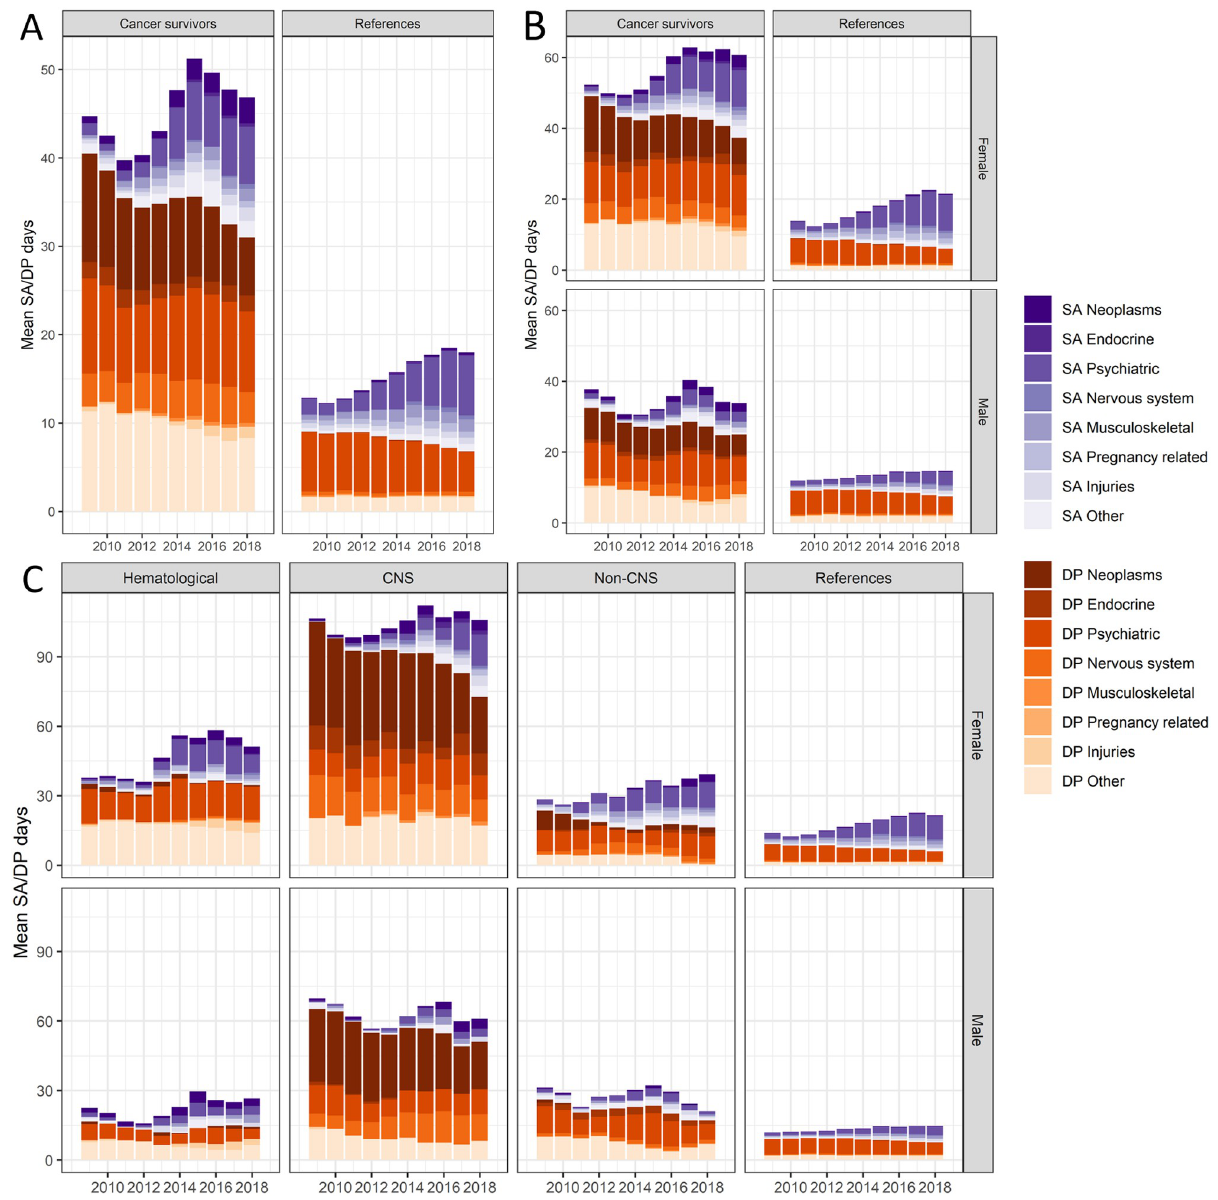
Fig 2. The annual mean number of sickness absence (SA) and disability pension (DP) net days in general and by type of SA and DP diagnoses in 2009 through 2018 among young adult childhood cancer survivors and their matched references (A); stratified by sex (B); and by sex and main types of childhood cancer